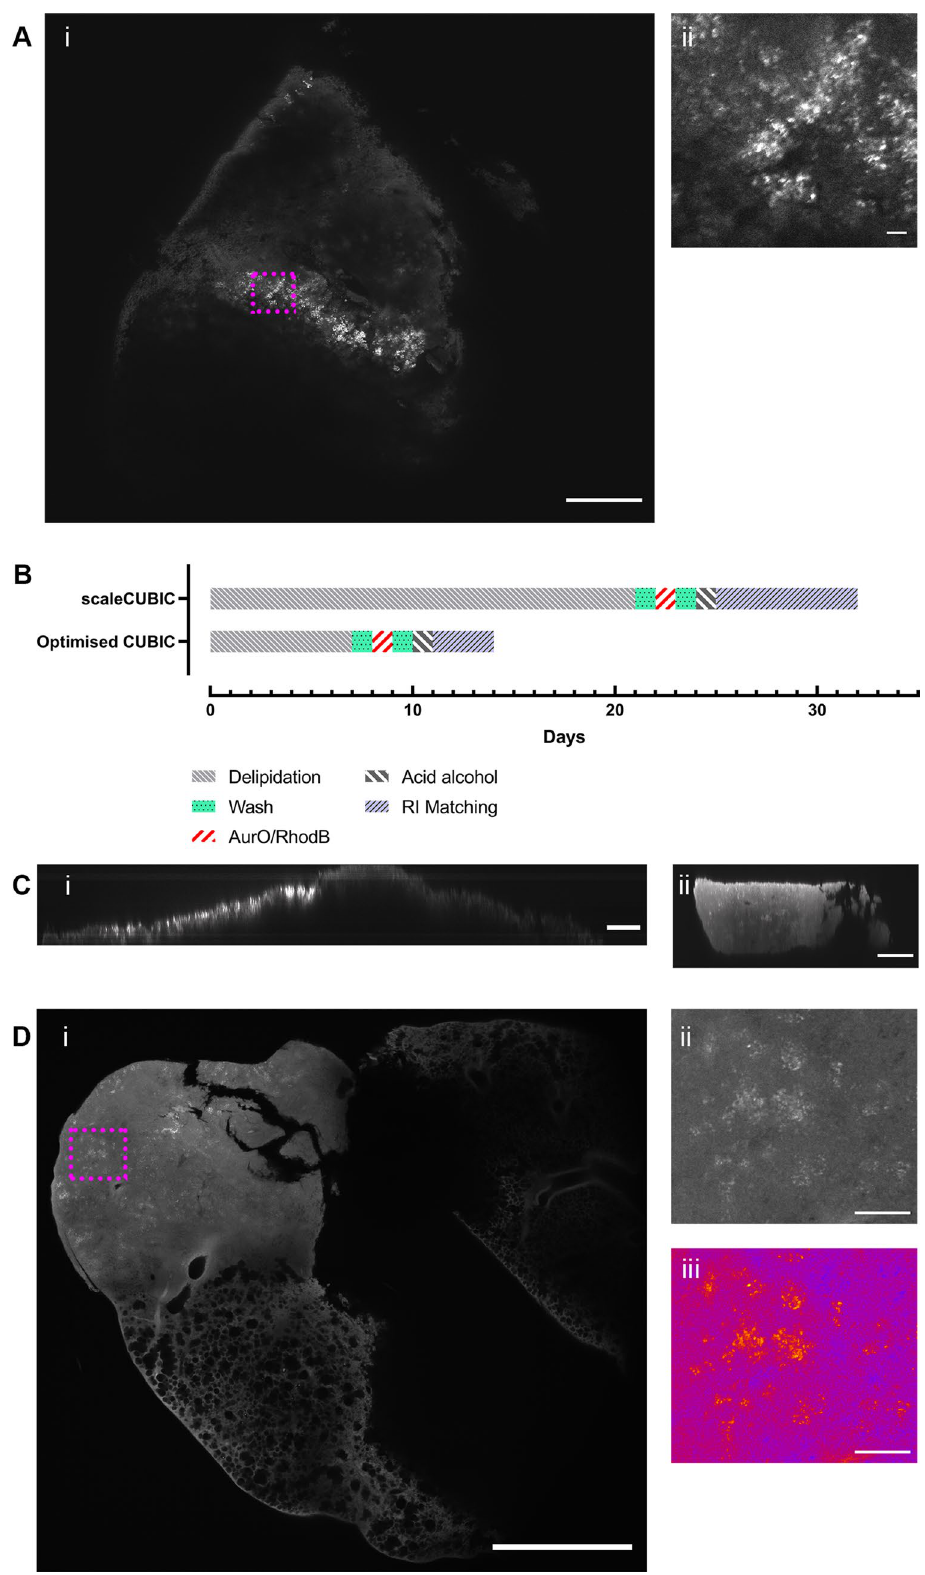
Figure 3. Mesoscopy of Mtb infected lung. Mtb can be visualized using CAF staining procedure in GC1237 infected mouse lung slice ( Ai ) with a speckly pattern not seen in naïve controls or in tissue without lesions (supplementary Fig. 4) and is present in a zoomed-in image ( Aii ). However, using optimised CUBIC reagents 30 processing time ( B ) can be reduced and the depth of imaging possible can be increased substantially, with scaleCUBIC ( Ci ) and comparable optimised CUBIC ( Cii ) presented. Using the optimised CAF procedure it is possible to see Mtb in a H37Rv infected sample ( Di ) and in zoomed-in images ( Dii ), with pseudo-colouring to highlight the speckled pattern ( Diii ). Scale bar = 500 µm ( Ai , Di ), 200 µm ( C ) and 20 µm ( Aii , Dii , Diii